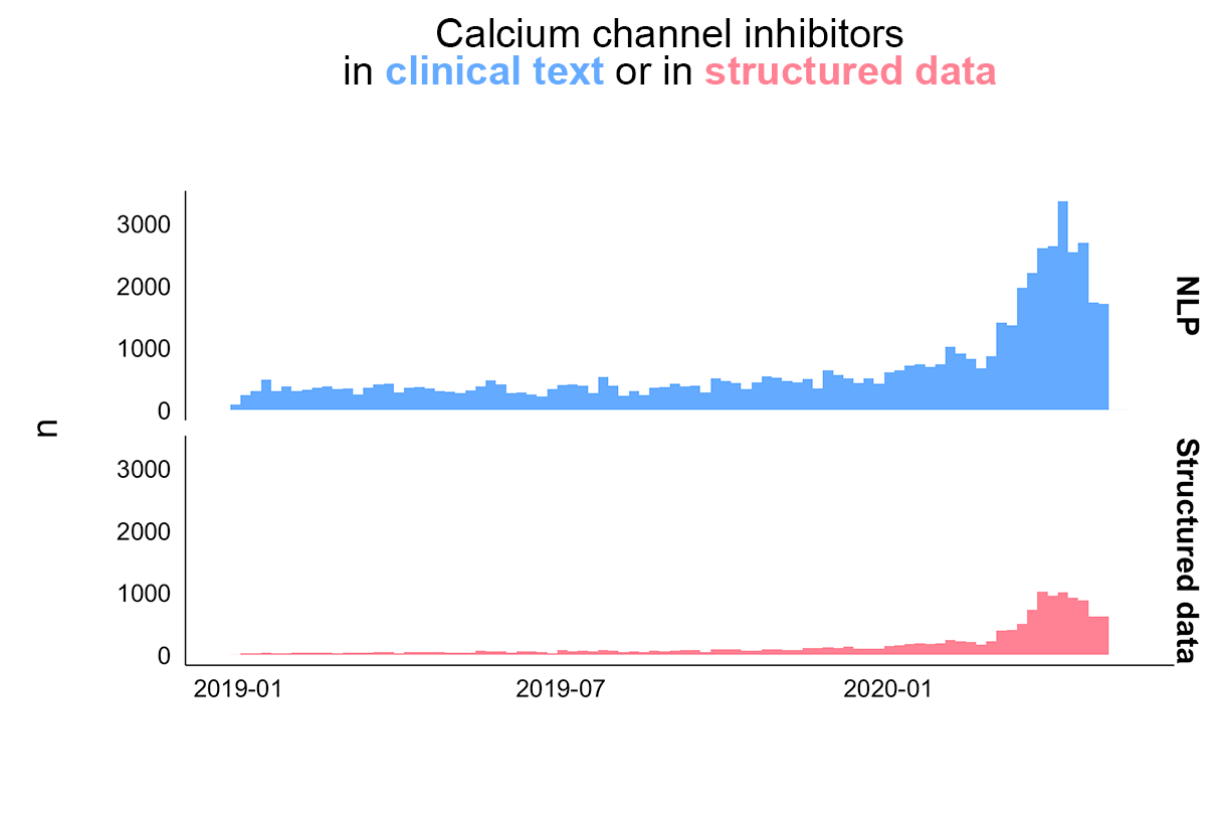
Figure 2. Quantity of information about calcium channel blockers for the two data sources over time. NLP: natural language processing.